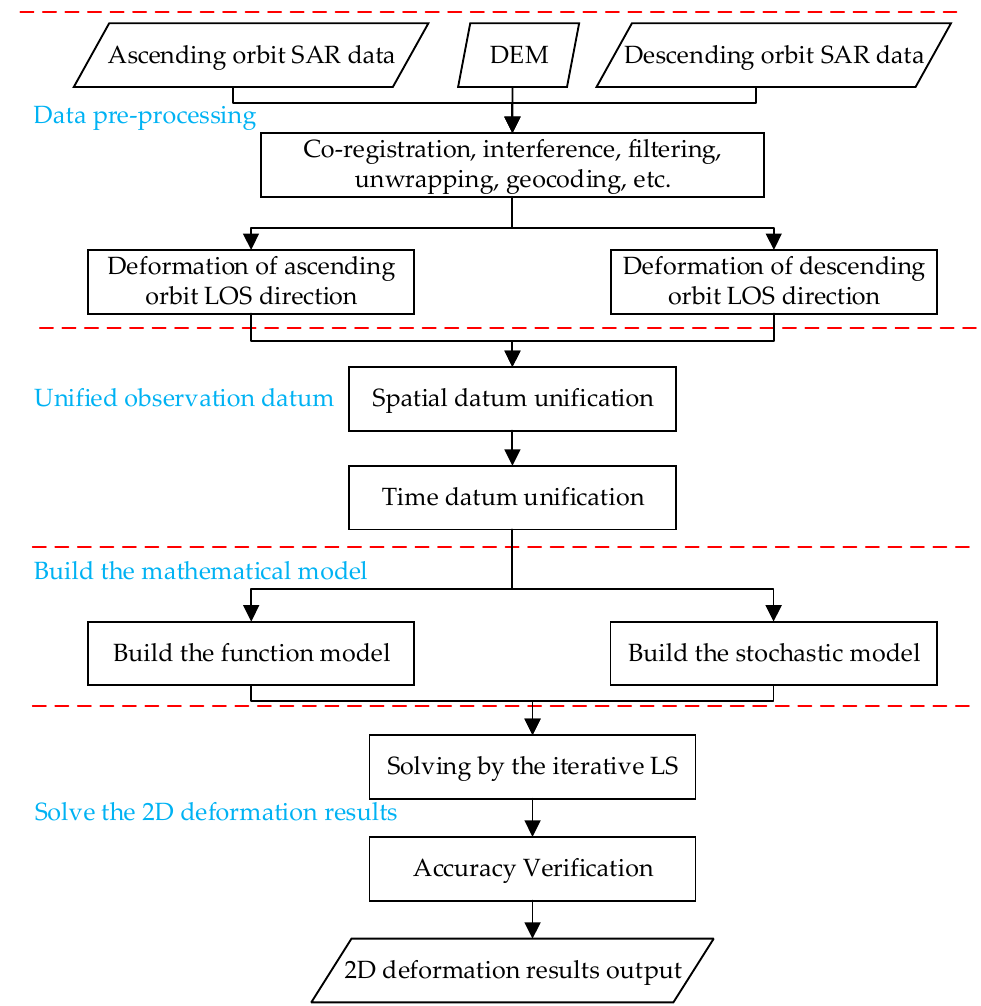
Figure 6. Flowchart of the proposed method.